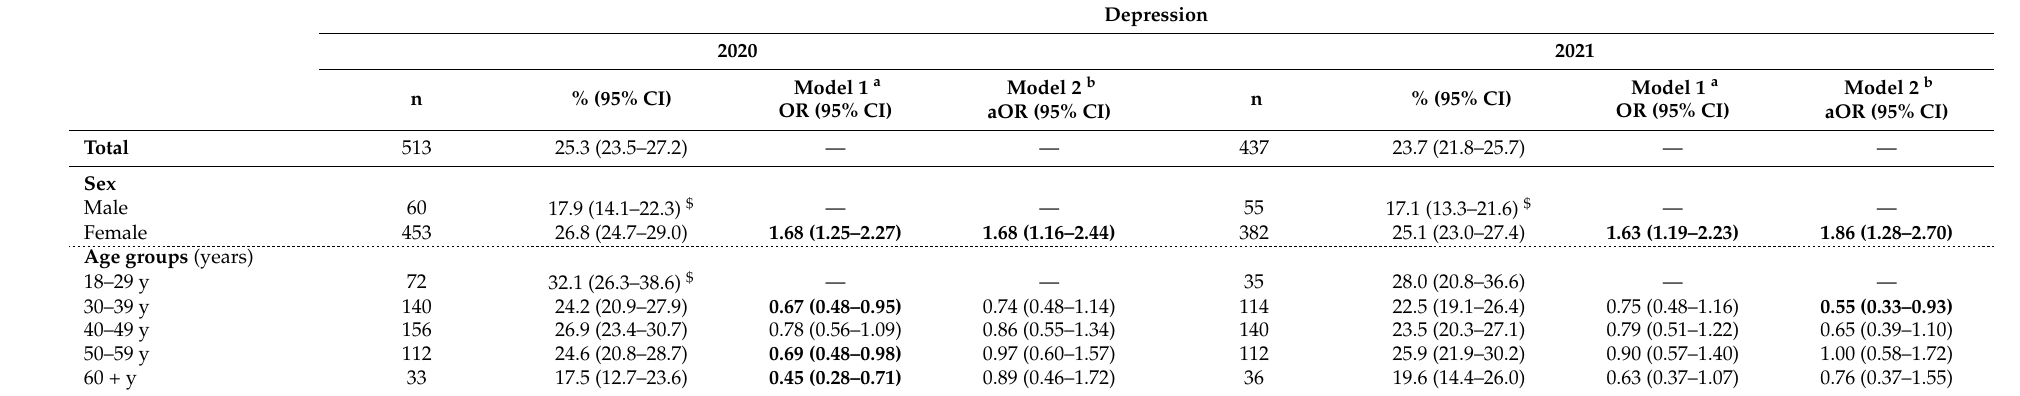
Table 3. Moderate to severe symptoms of depression among HCPs during the first two years of COVID-19 pandemic in